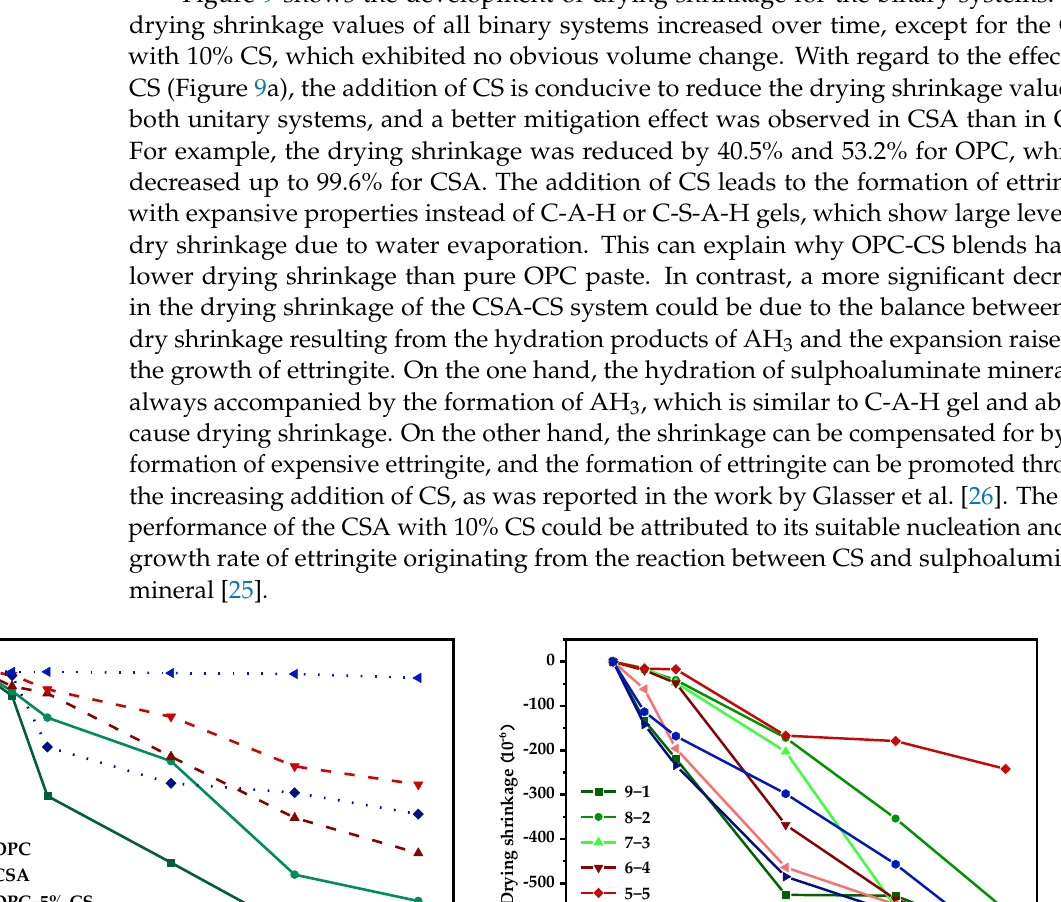
( b ) Figure 10. Drying shrinkage values of different pastes: ( a ) with 5% CS; ( b ) with 10% CS.